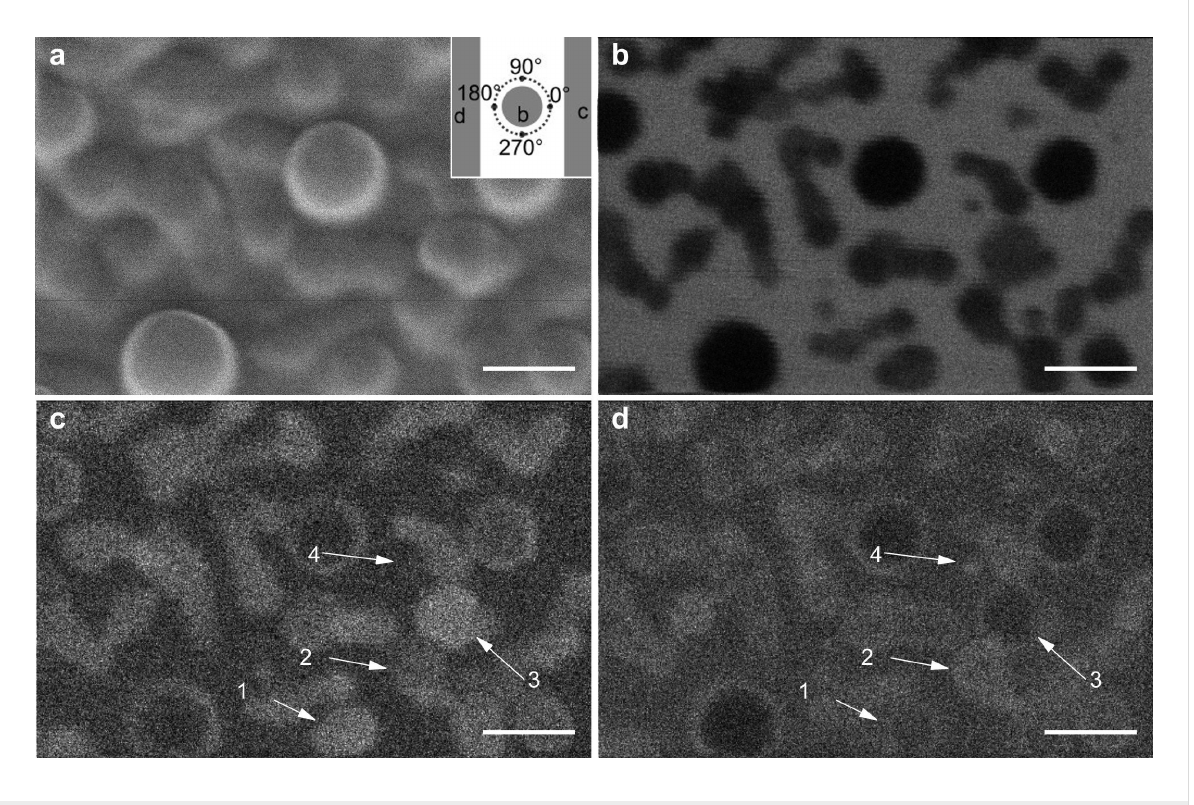
Figure 5: Thallium chloride evaporated on a TEM grid. (a) Secondary electron image. Inset of (a) shows the regions of the detector used to generate the following STIM images. (b) BF STIM image with acceptance angle of 0 to 4°. (c) DF STIM using the signal from the region on the right. (d) DF STIM using the signal from the region on the left. The scale bars are 100